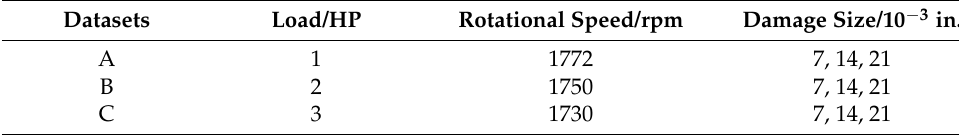
Table 6. Three different working conditions. Figure 5. CWRU. Bearing fault diagnosis test plat. Figure 6. Generate sample with overlap.